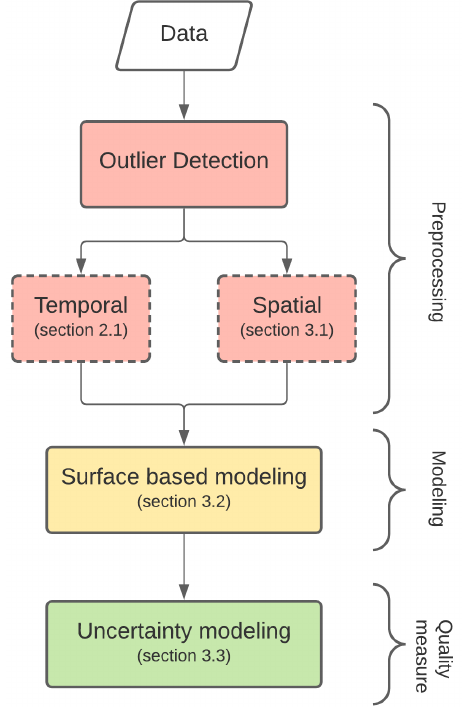
Figure 2. Flowchart of the main methodologies